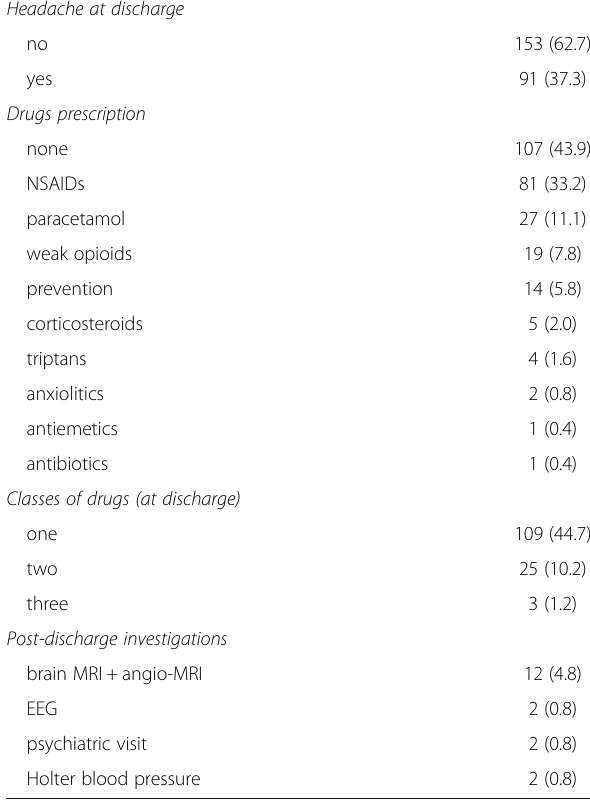
Table 5 Discharge from the emergency department